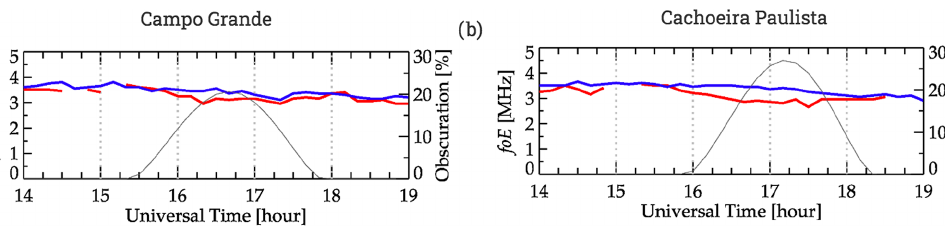
Figure 8. E region critical frequency ( fo E) in (a) CG and (b) CXP between 14:00 and 19:00UT. The parameters are presented by the blue line for the quietest day of the month (4 December 2020), and the red line refers to the solar eclipse on 14 December 2020. The grey line represents the solar eclipse obscuration for each region in